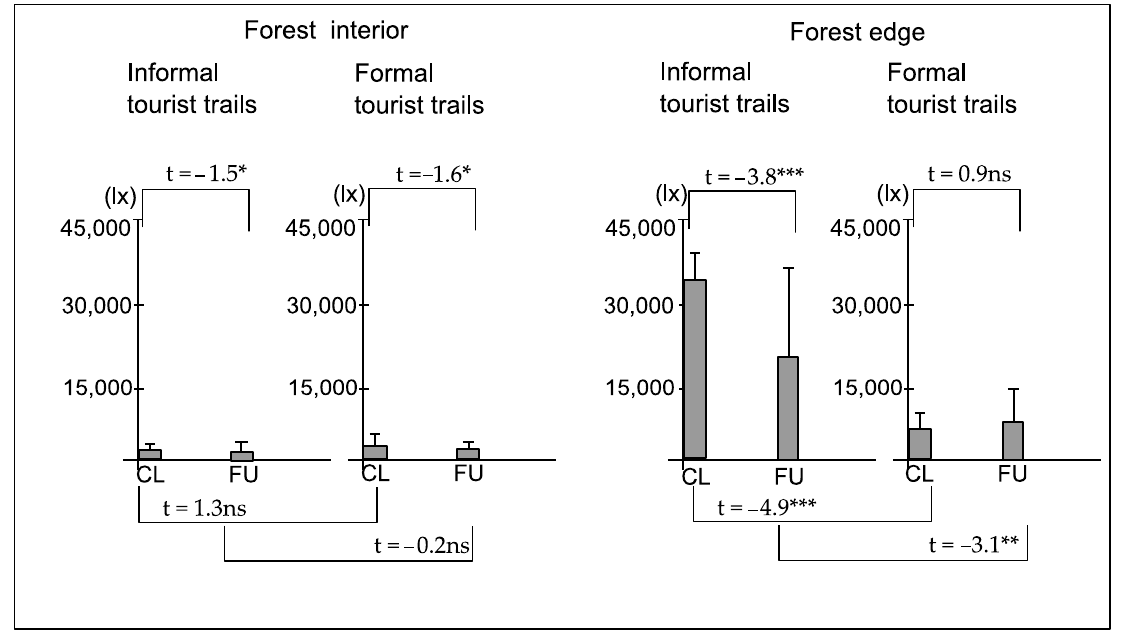
Figure 2. The mean values of light intensity (lx) at ground level (±SD) in closer (CL) and further (FU) plots located along informal (width < 50 cm) and formal (width > 150 cm) tourist trails within the forest interior and forest edge sites. The statistical significance level: ns- not significant, * p ≤ 0.05, ** p < 0.01, *** p < 0.001.